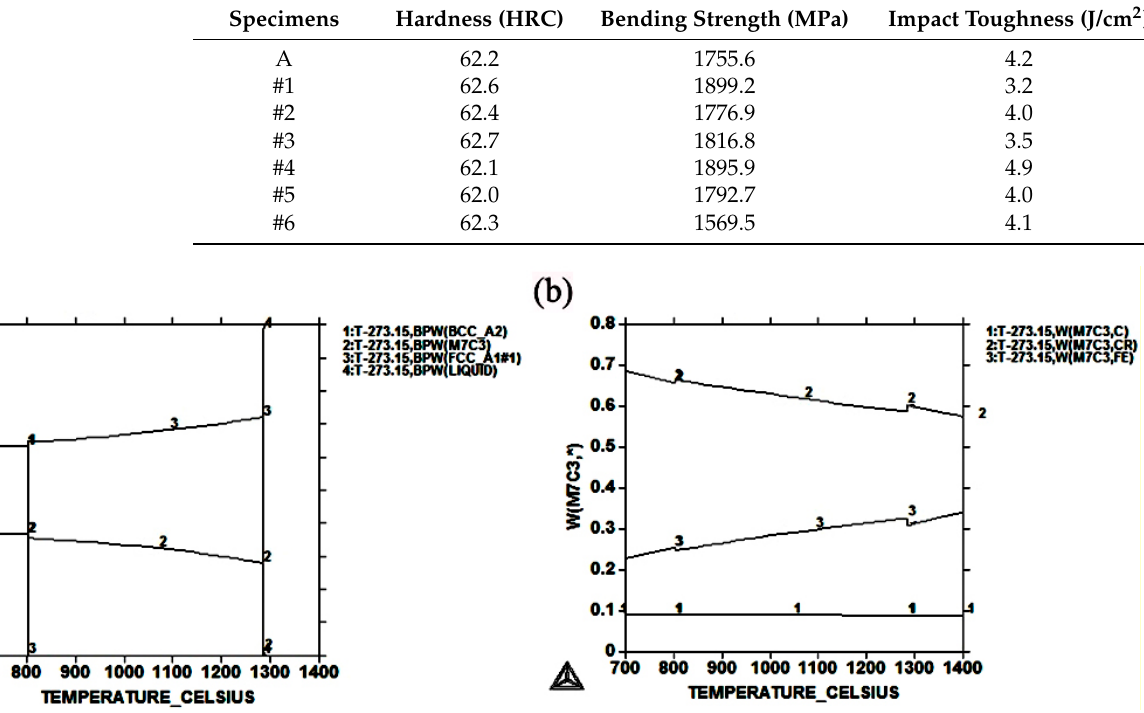
Figure 6. ( a ) variation in phase of HCCI and ( b ) variation in Fe, Cr, and C contents of M 7 C 3 during solidification: all obtained using Thermo-Calc.